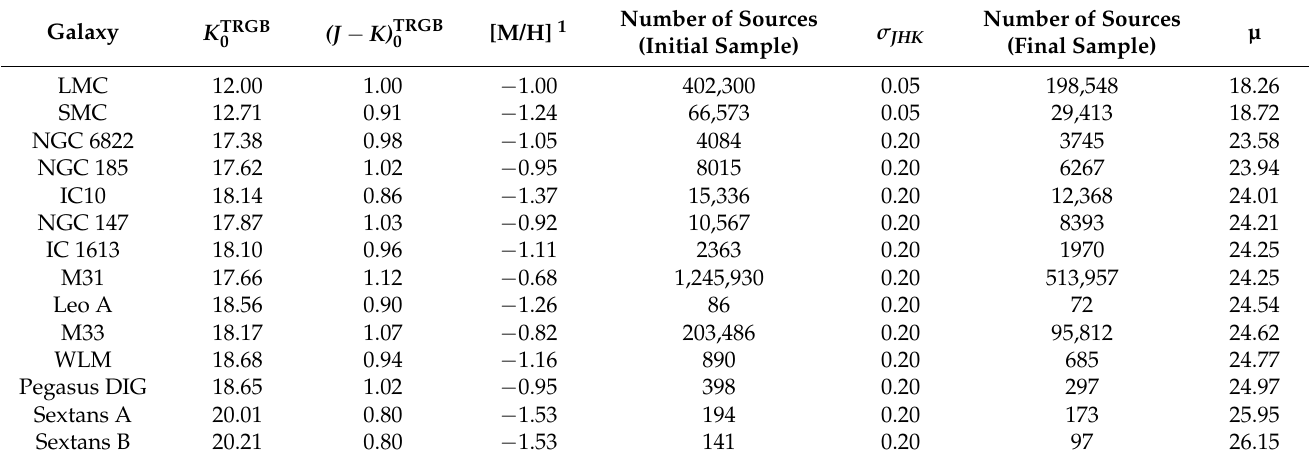
Table 1. The basic information of the 14 sample